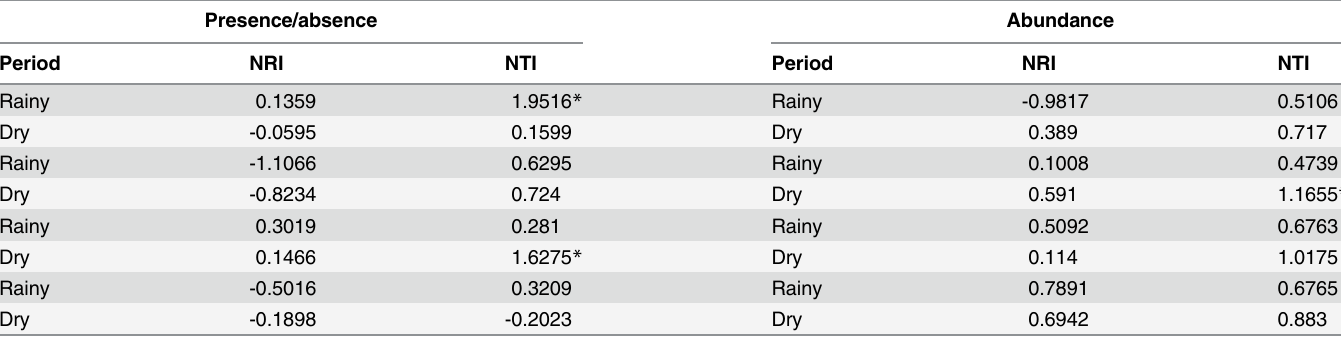
Table 1. NRI and NTI index values for the anuran communities in rainy and dry periods at Nhumirim Ranch, Pantanal wetland, Brazil, using pres- ence/absence and abundance metrics.